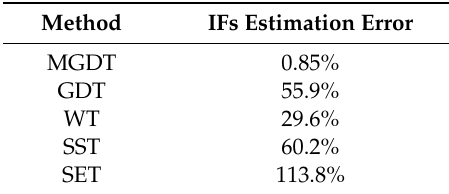
Figure 9. Comparison results: TFRs obtained by ( a ) wavelet transform (WT), ( b ) synchrosqueezing transform (SST) and ( c ) synchro-extracting transform (SET); and ( d ) extracted IFs from TFRs, the actual IF and IF, extracted by the MGDT technology. Table 1. IF estimation errors for different methods.